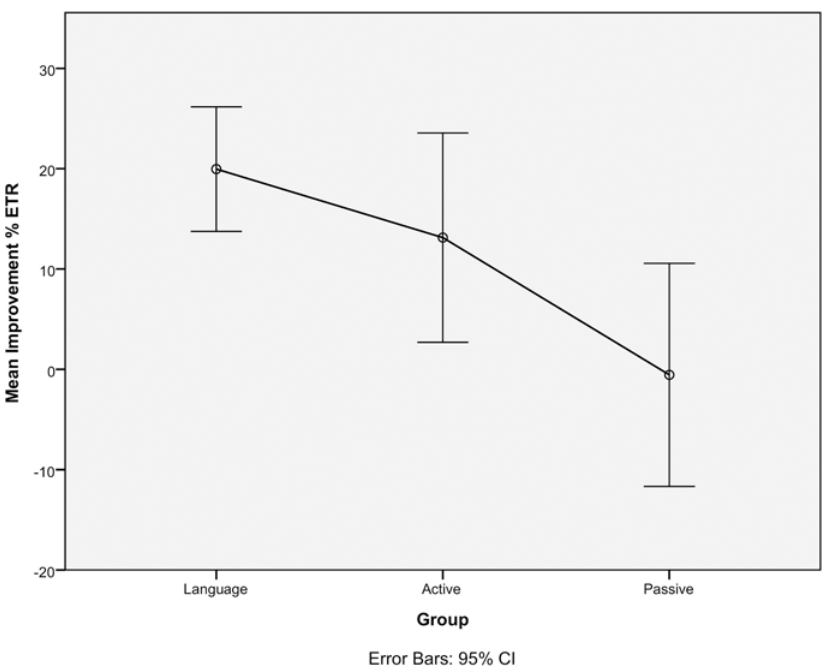
Fig 1. Linear trend performance on the Elevator Task with Reversal for the Language, Active, and Passive Control Groups.